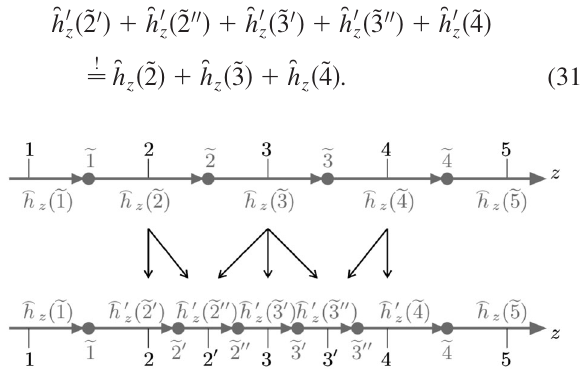
FIG. 6. Interpolation of magnetic grid voltages oriented per- pendicularly to the refinement. The voltages ̑ h ̑ h ð ~4 Þ , assigned to coarse grid edges, are split and distributed z such that the total magnetic voltage in between the nodes is preserved [cf. Eq. (31)]. The voltages on the refined grid are determined according to Eqs.